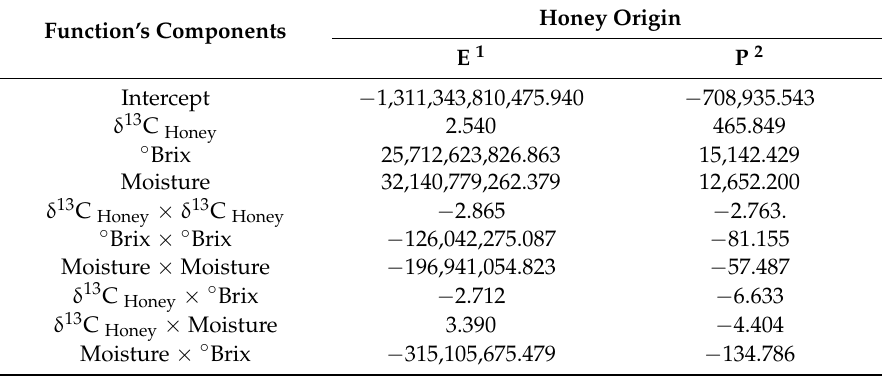
Table 3. Intercept and coefficients of the quadratic discrimination function.